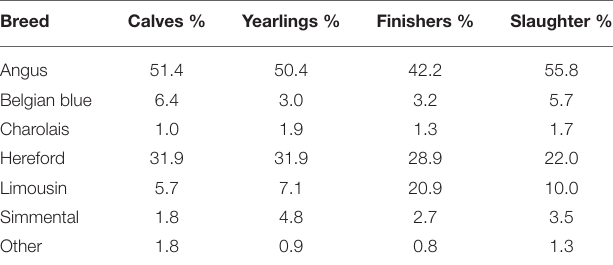
TABLE 3 | Frequency of the breed of beef sire used by system. Breed Calves % Yearlings